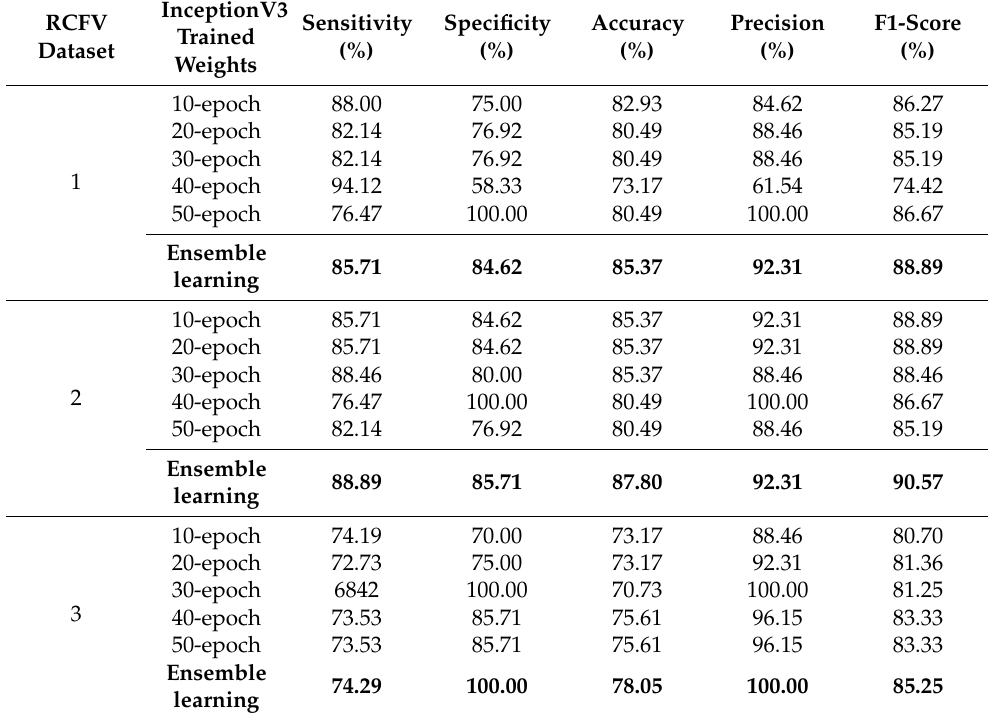
Table 9. The InceptionV3 performances of specified weights with ensemble learning.